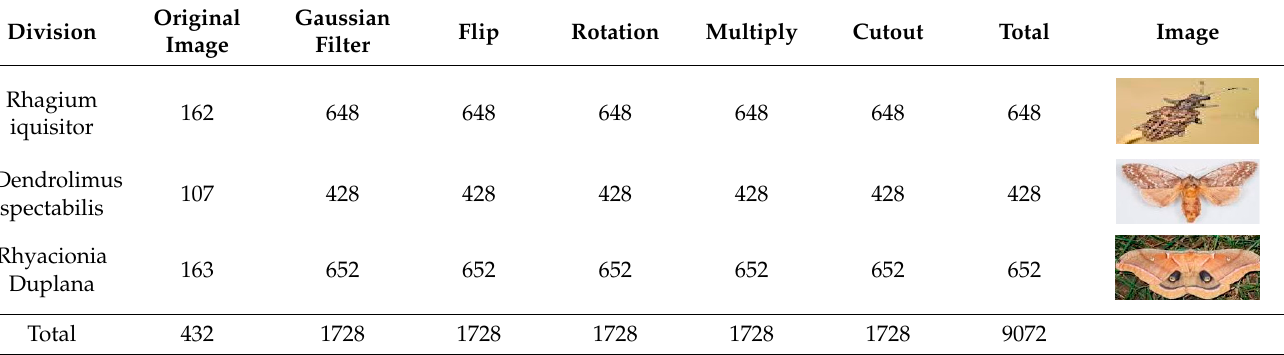
Table 2. Data quantity results using model of data augmentation technique.